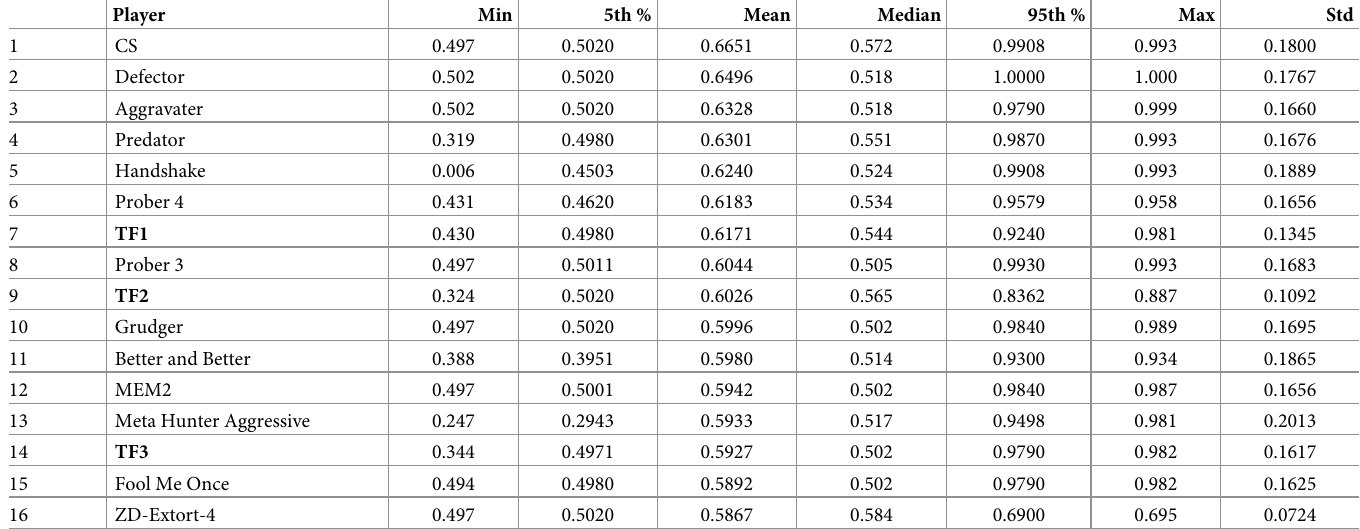
Table 4. Top strategies for N = 2 (neutral fixation is p =